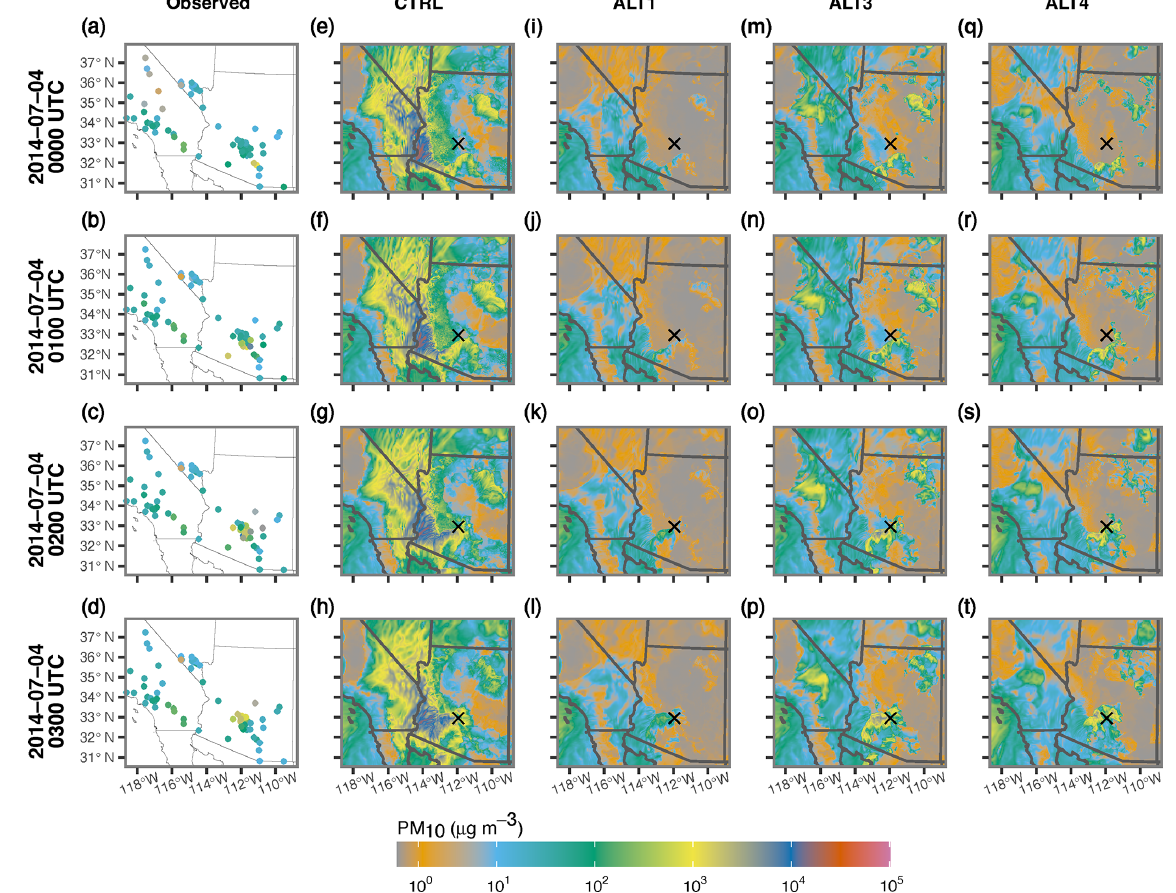
Figure 12. Times series of observed and simulated PM 10 concentration for each test configuration (CTRL, ALT1, ALT3, and ALT4) (µgm − 3 ) from 00:00 to 03:00UTC on 4 July 2014. The black × marks the location of Phoenix, Arizona. The ALT2 configuration results are not included in this figure since they are nearly identical to results from the ALT1